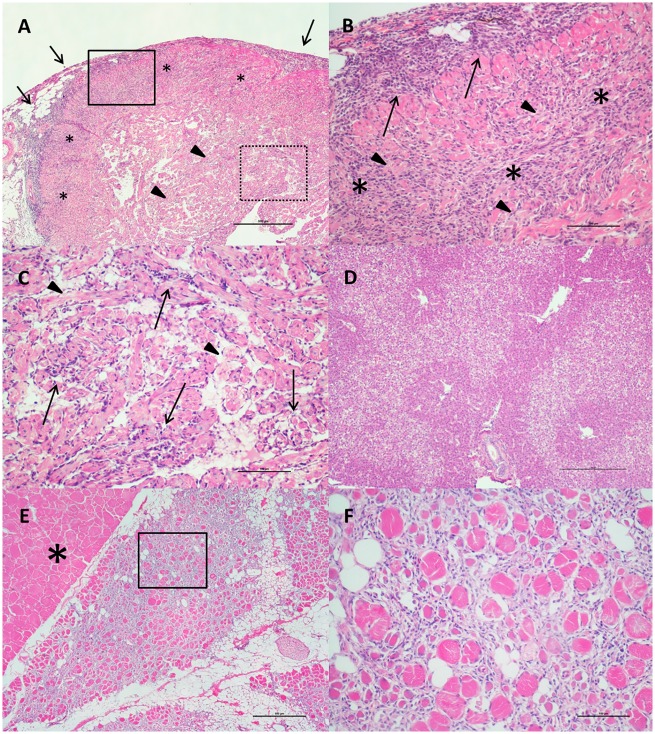
Heart and Skeletal Muscle Inflammation (HSMI) lesions in BC farmed Atlantic salmon (H&E).A) Severe diffuse/ infiltrative panmyocarditis, involving the epicardium (arrows) and the compact layer of the myocardium (stars). The spongy layer is also involved in widespread inflammatory nodules (arrowheads). Bar scale: 500μm. B) Solid line inset of Fig A. The inflammatory infiltrate comprises mononuclear cells (lymphocytes and macrophages) in both epicardium (arrows) and compact myocardium (stars). Along with the inflammation, myocardial degeneration and necrosis are also visible (arrowheads). Scale bar: 100μm. C) Dashed line inset of Fig A. Multiple foci of endo-myocarditis (arrows) and myocardionecrosis (arrowheads) in the spongy layer of the myocardium Scale bar: 100μm. D) Severe diffuse zonal degeneration and necrosis in liver. Scale bar: 250μm. E) Severe diffuse infiltrative myositis in skeletal muscle. Note the white portion of the muscle (star) completely unaffected by the inflammatory reaction. Scale bar: 500μm. F) Inset of Fig E. Severe myonecrosis (along with some regenerating muscle cells) and infiltrating mononuclear cells inflammation are evident. Scale bar: 100μm.